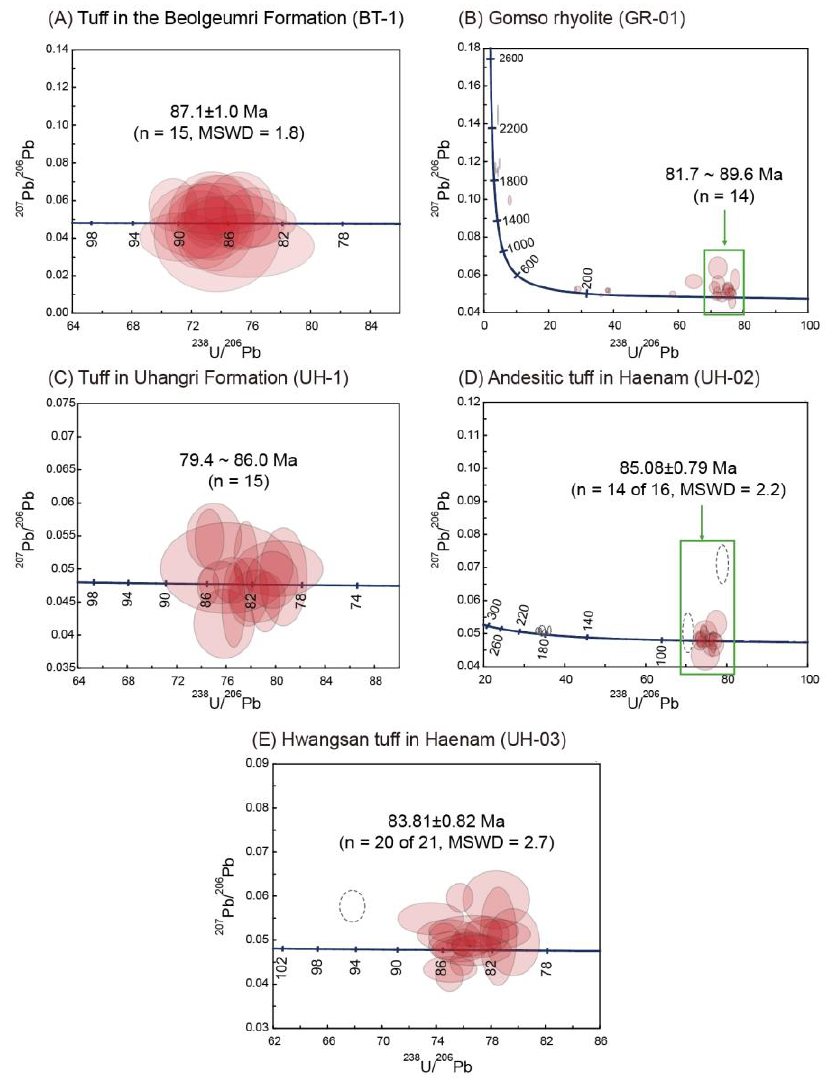
Figure 6. Concordia plots of the SHRIMP U-Pb isotopic analyses of zircons from ( A ) the tuff in the Beolgeumri Formation, ( B ) the Gomso Rhyolite, ( C ) the tuff in the Uhangri Formation, ( D ) the andesitic tuff, and ( E ) the Hwangsan tuff with analyzed points and ages. Gray dotted ellipsoids were excluded from weighted mean calculations.